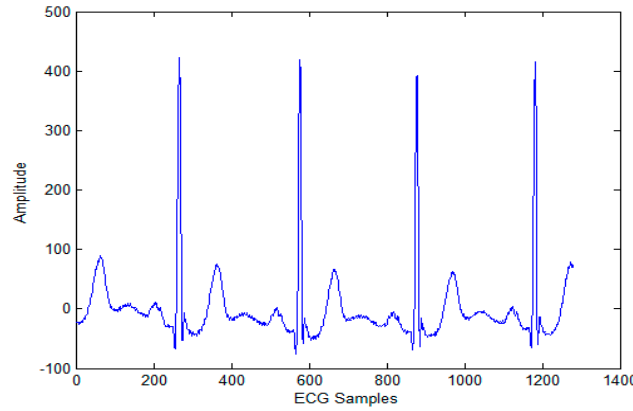
Figure 5. Watermarked ECG.